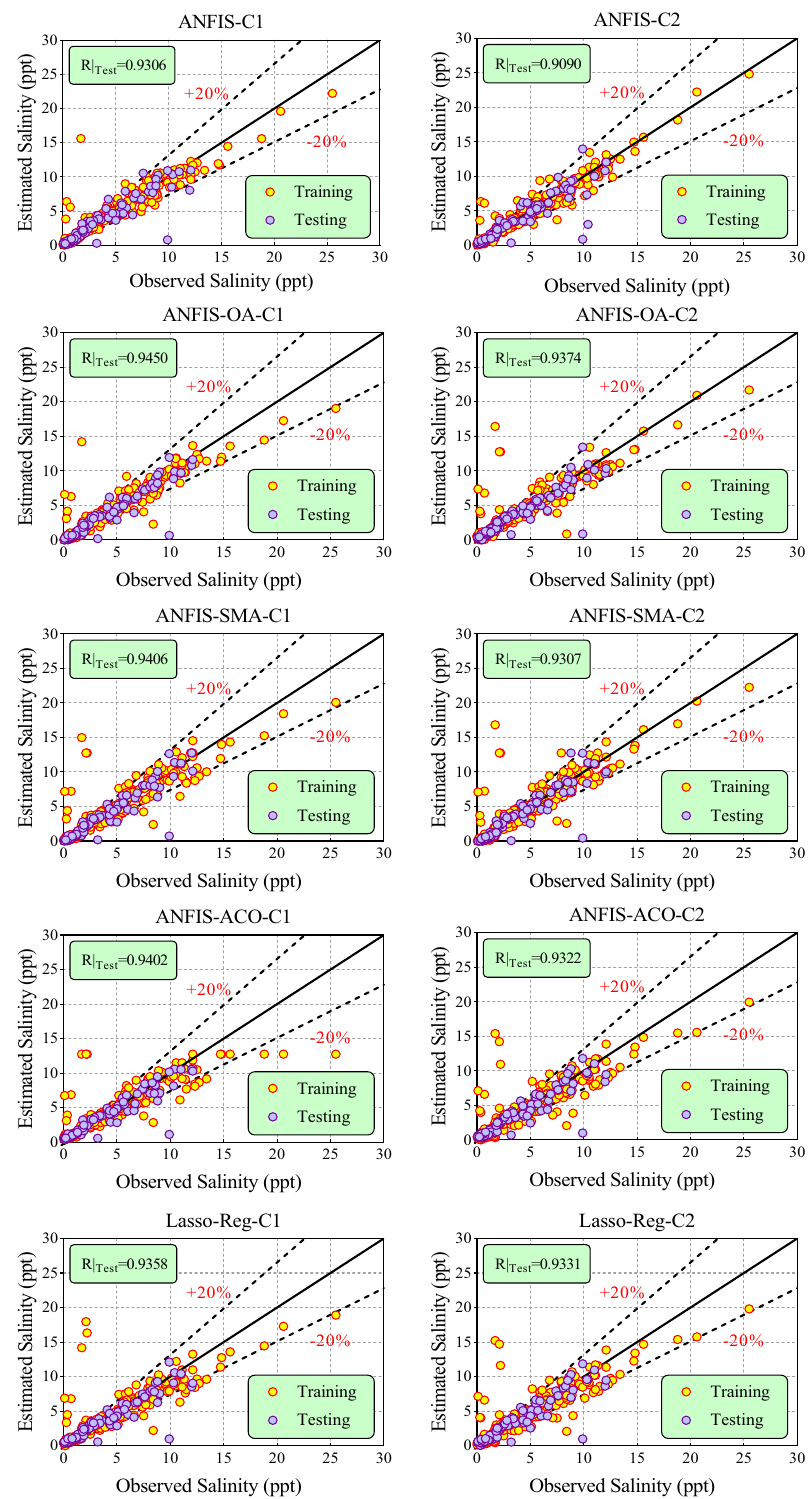
Figure 8. Scatter plot of observational and predicted values of salinity of groundwater using the provided models in all the